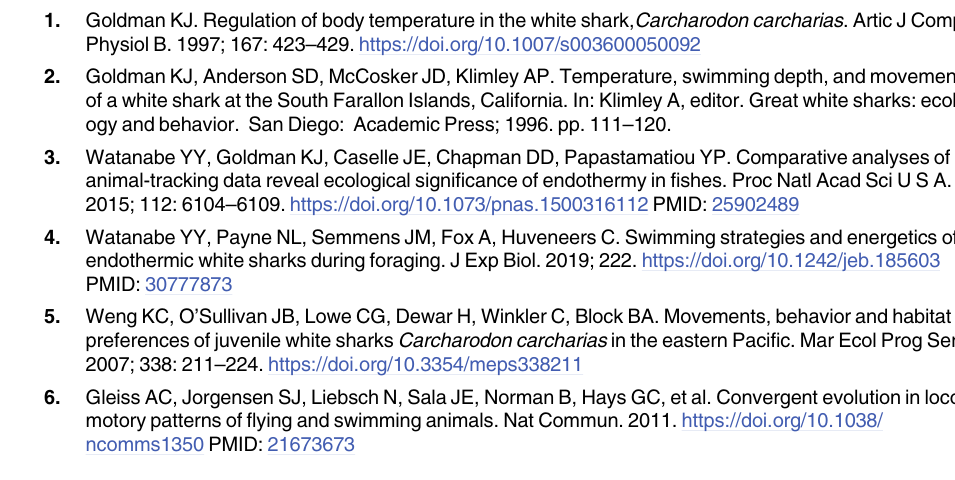
S1 Fig. Violin plot of distributions of calculated swim speeds for each shark included in the study, colored according to sex. S2 Fig. Regressions of estimated O2 consumption rates against shark body mass. Relation- ships between O consumption and body mass are governed by the scaling coefficient used in 2 the general equation log MO = log (SMR) + coeff .( U ). Points and lines show values gener- 10 2 10 ated according to coefficients of 0.58 (magenta; used by Semmens et al. 2013), 0.79 (green; the allometric scaling used by Ezcurra et al. (2012) and Payne et al (2015), and 0.97 (blue; used by Watanabe et al.